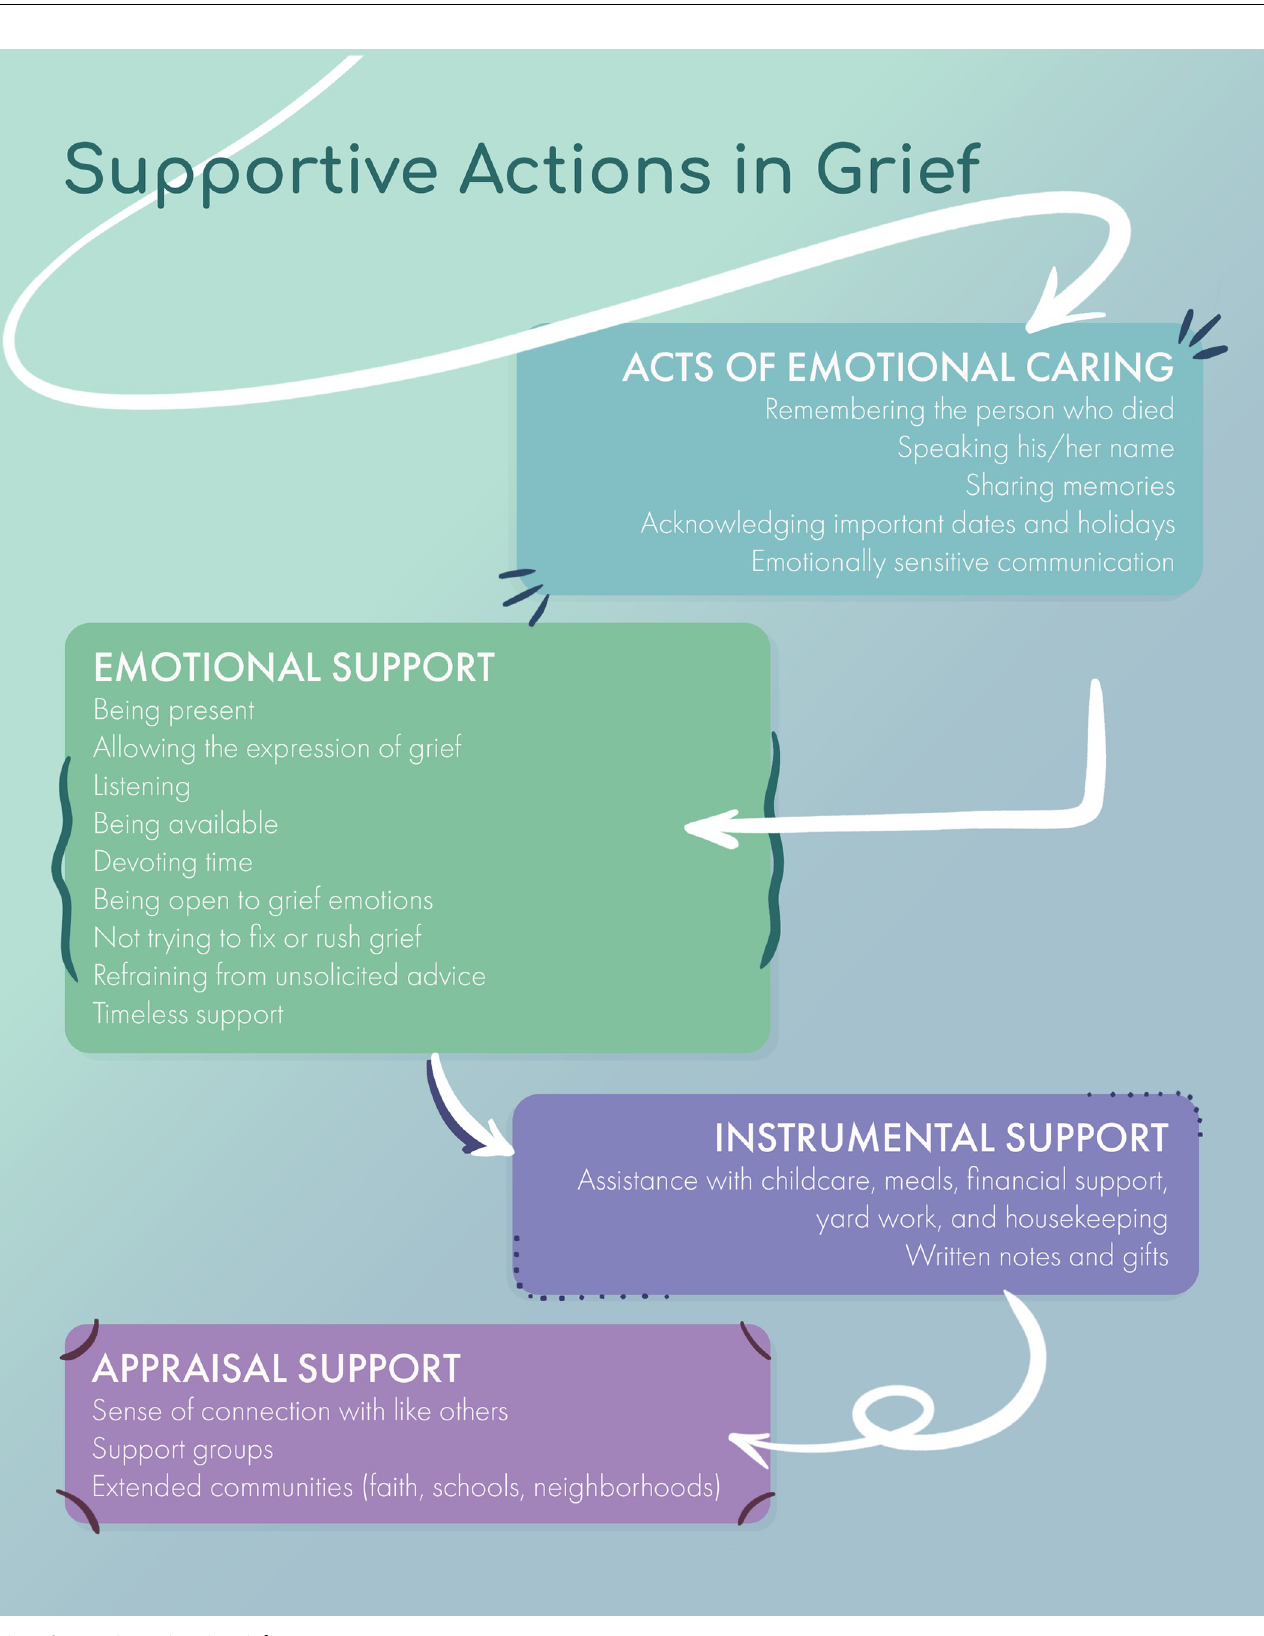
Fig 1. Supportive actions in